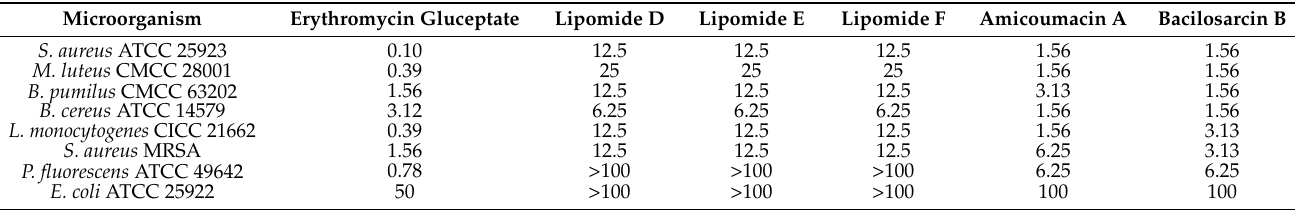
Table 3. MIC values of lipomide D–F, 1 – 3 , amicoumacin A, 7 , and bacilosarcin B, 11 , toward selected microorganisms ( µ